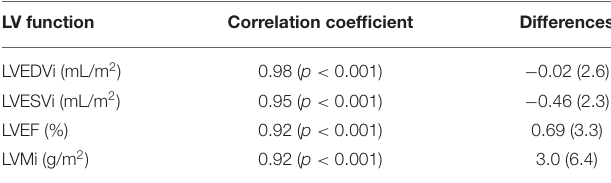
TABLE 5 | Comparisons of indexed LV volumes, ejection fraction and mass from the 155 test cases between the predicted segmentation results with manual contours.